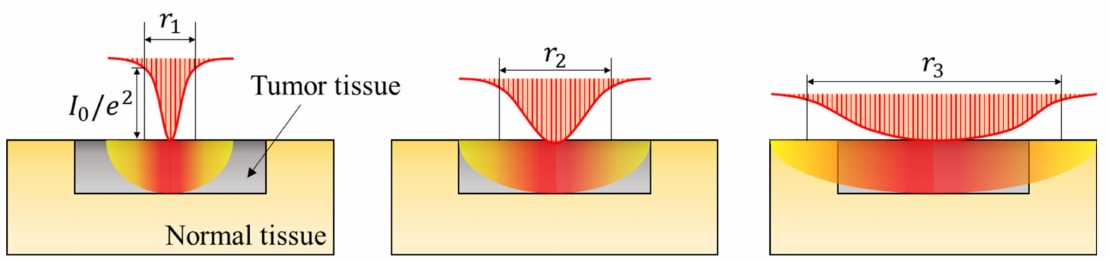
Figure 9. Profile changes for a radius increase in the Gaussian laser profile.